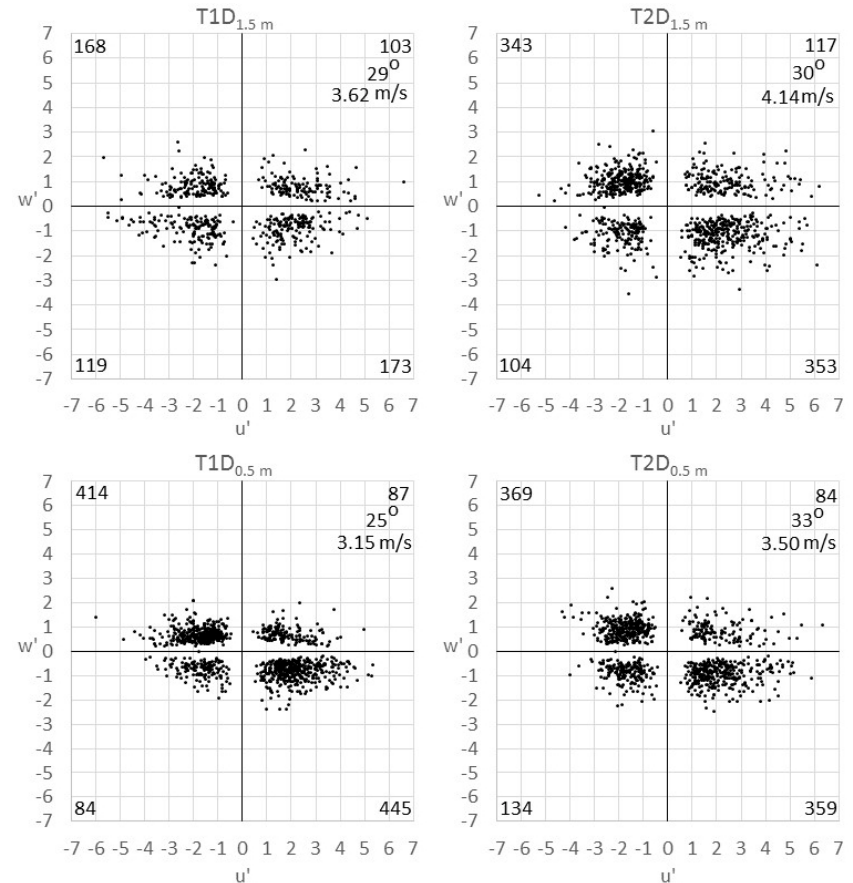
Figure 14. Dune (T1D and T2D) Quadrant plots (1 Hz) for all runs (80 min, n = 4800). For each quadrant, values for significant activity (>1 standard deviation) are shown in the corner. The top right-hand corner also displays the incident flow angle (0° is alongshore, 90° is onshore), and wind speed (S).